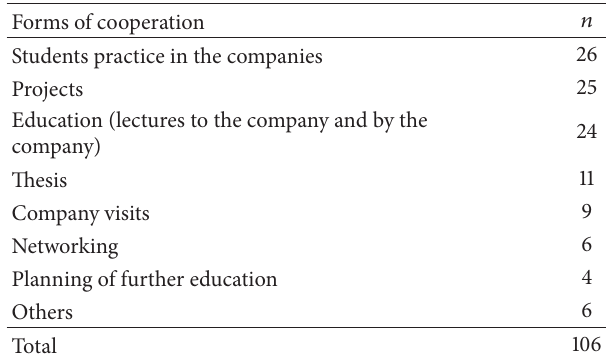
Table 5: The cooperation forms between health care teachers